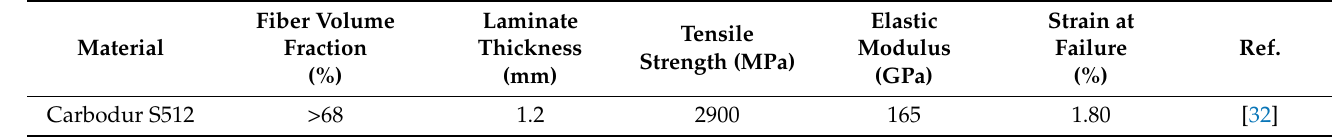
Table 2. Technical information of Carbodur S512 as reported in the Product Data Sheet [33], according to EN